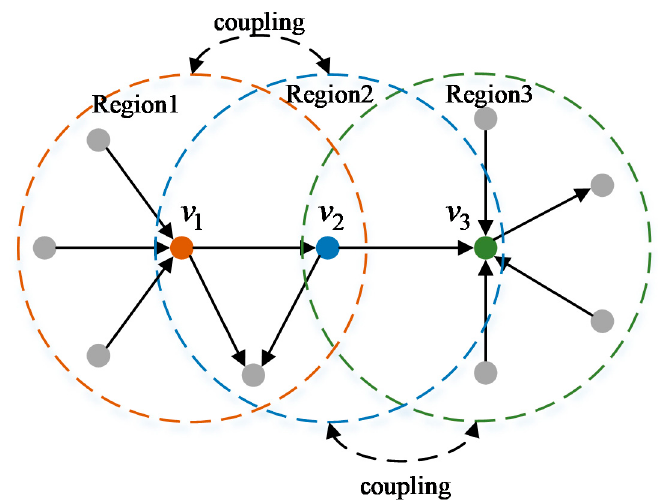
Figure 1. Electrical coupling of multiple regions.